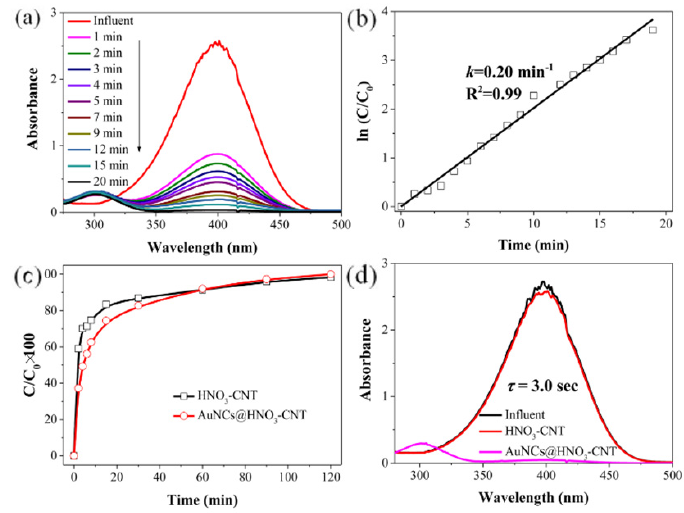
Figure 14. ( a ) Time-dependent UV–vis absorption spectra from 280 to 500 nm and ( b ) the rate kinetics for the conversion of 4-NP in a conventional batch reactor using the AuNCs / CNTs hybrid membrane. ( c ) Breakthrough curves of 4-NP only (without the addition of any NaBH 4 ; the data was obtained at the wavelength of 317 nm). ( d ) Comparison of the UV–vis absorption spectra before and after passing through the AuNCs / CNTs hybrid membrane and the HNO 3 -CNTs membrane [234].